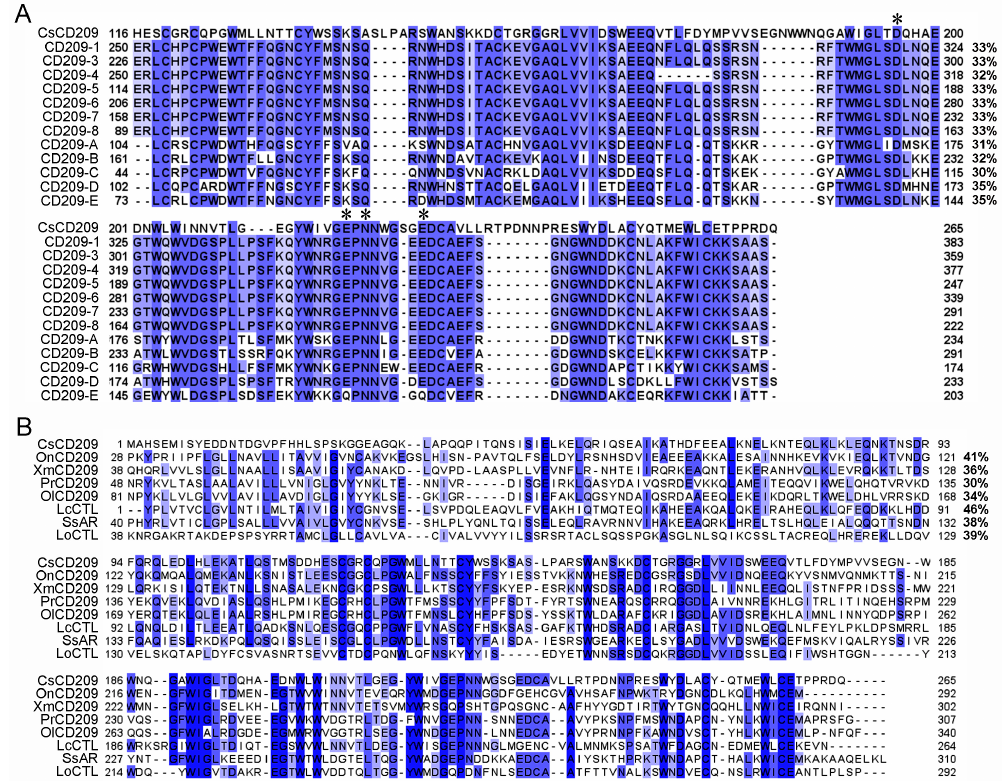
Figure 2. Multiple alignment of CsCD209 with other CD209/lectin proteins. ( A ) Multiple alignment of the lectin domains of CsCD209 and CD209 from Homo sapiens (CD209-1, -3, -4, -5, -6, -7 and -8) and Mus musculus (CD209-A, -B, -C, -D and -E) that share 30–35% similarities with CsCD209 (right side of the alignment). The conserved amino acid residues involved in mannosylated glycan interaction are indicated with asterisks; ( B ) Multiple alignment of full-length CsCD209 homologues from teleost fishes. OnCD209: Oreochromis niloticus CD209, XmCD209: Xiphophorus maculates CD209, PrCD209: Poecilia reticulate CD209, OlCD209: Oryzias latipes CD209, LcCTL: Larimichthys crocea C-type lectin, SsAR: Salmo salar asialoglycoprotein receptor, LoCTL: Lepisosteus oculatus C-type lectin. In both ( A ) and ( B ), dots denote gaps introduced for maximum matching. The blue shadow color indicates a similarity between sequences, with darker shades meaning greater similarities.